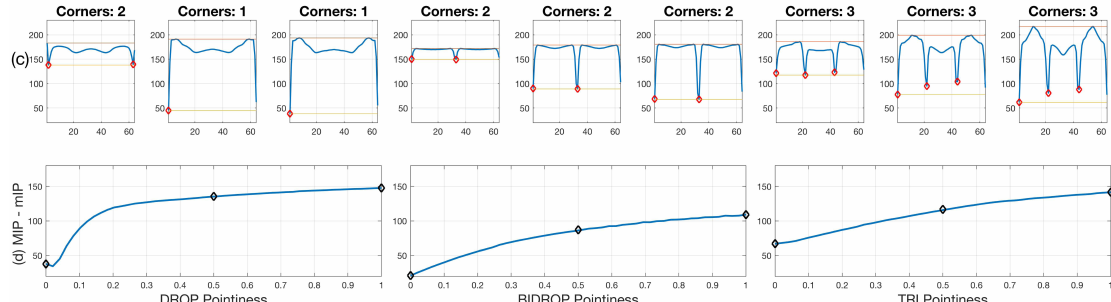
Figure 10. Pointiness assessment of the drop, bidrop and tridrop shapes, see full explanation in text. For each shape presented, three instances of the shape are shown with varying pointiness values; the relationship of the anglegram and the pointiness is shown. The columns are arranged in triads corresponding to each of the basic shapes. Notice that, in all cases, the difference between the maximum and minimum values of the mIP (solid lines in third row) grows proportionally to the pointiness level.